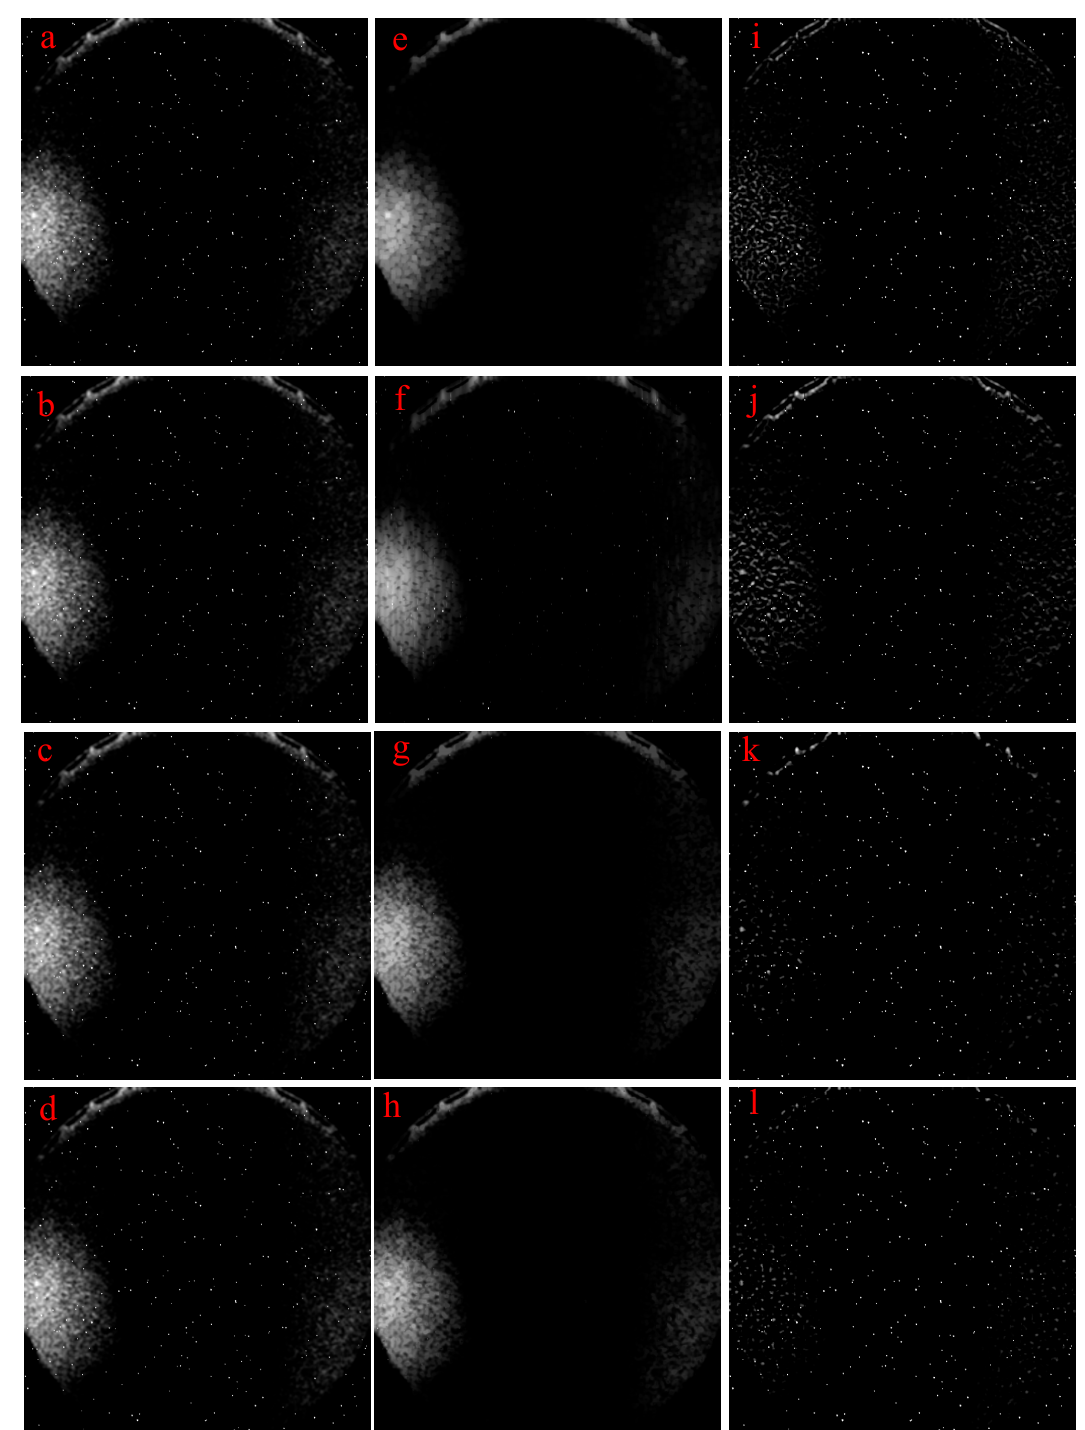
Figure 10. Elimination result for the second type of stray light background. ( a – d ) Simulated original surveillance images; ( e – h ) nonuniform backgrounds estimated by the THT, MIF, INTHT, and IBSGM methods, respectively; and ( i – l ) background elimination results of the THT, MIF, INTHT, and IBSGM methods, respectively. For the evaluation of the reference image, we use the root mean square error (RMSE) to evaluate the effect of nonuniform background elimination. Here, O and I are the